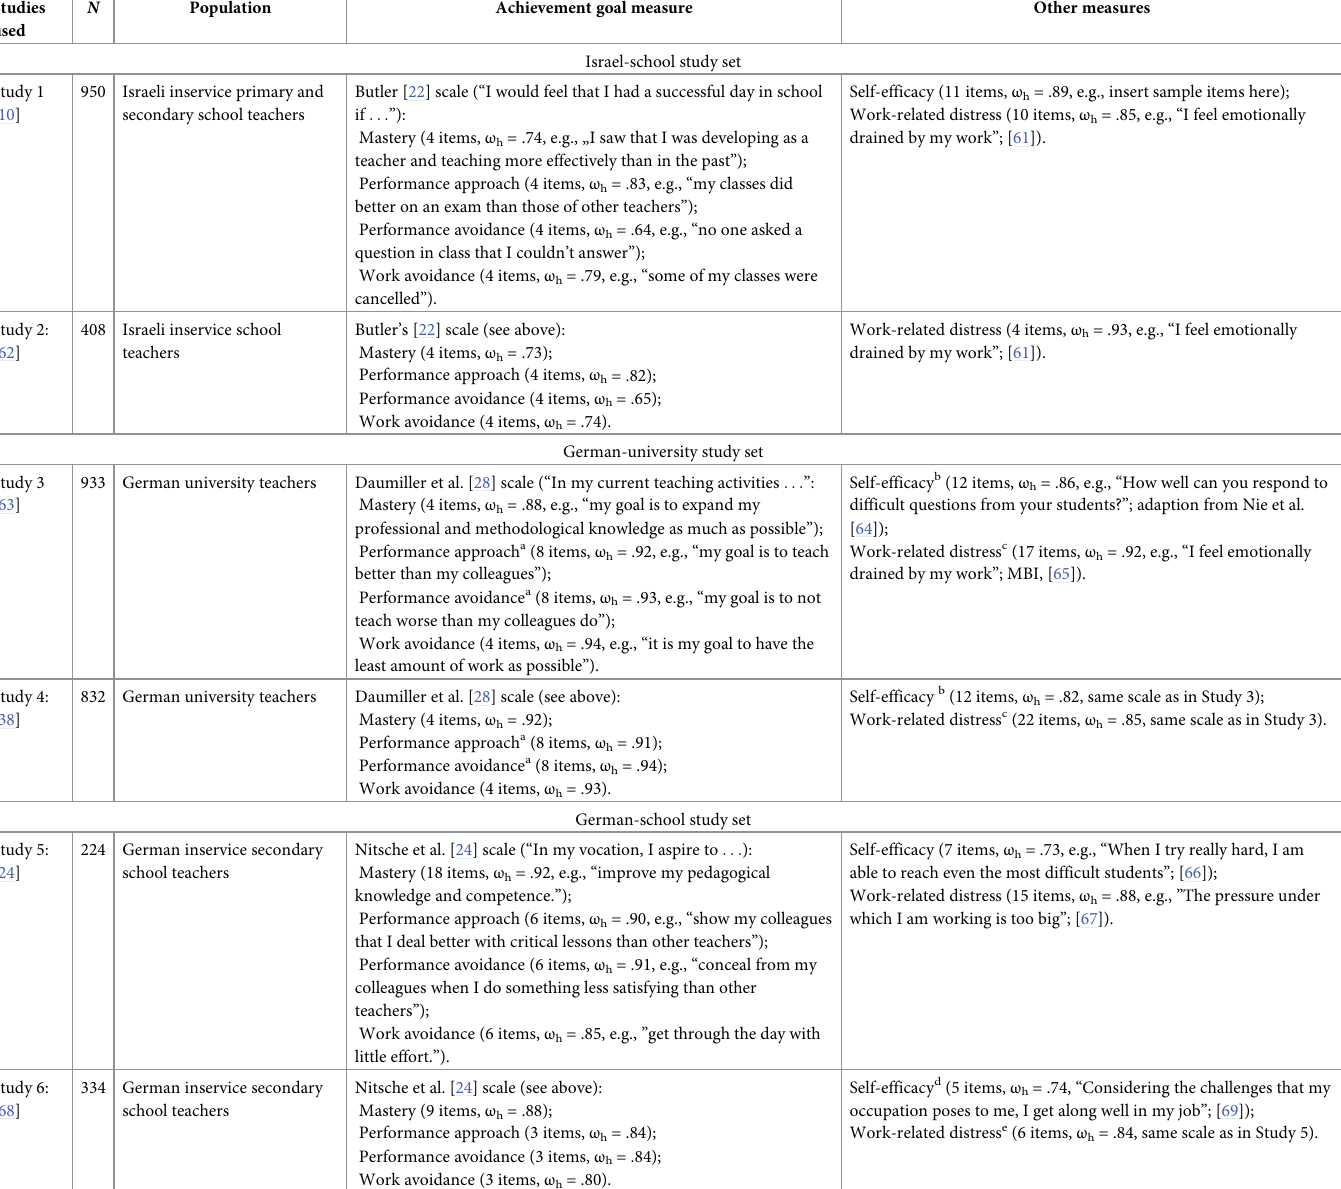
Table 1. Overview of the included